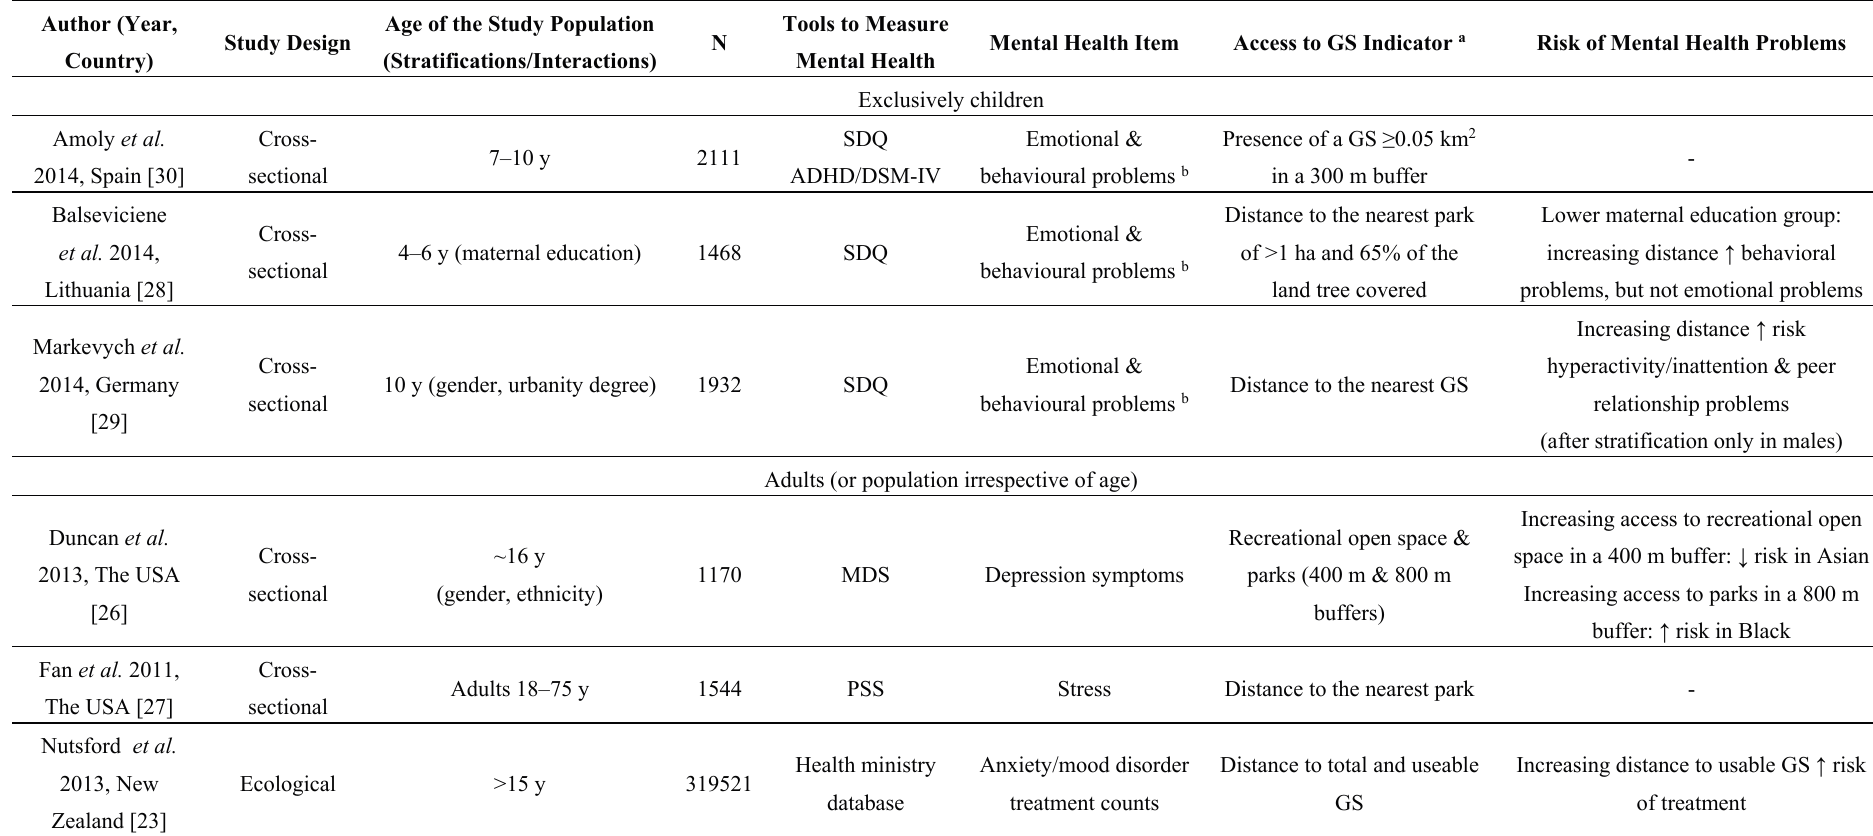
Table 2. Main characteristics and results of the studies on access to green spaces and mental